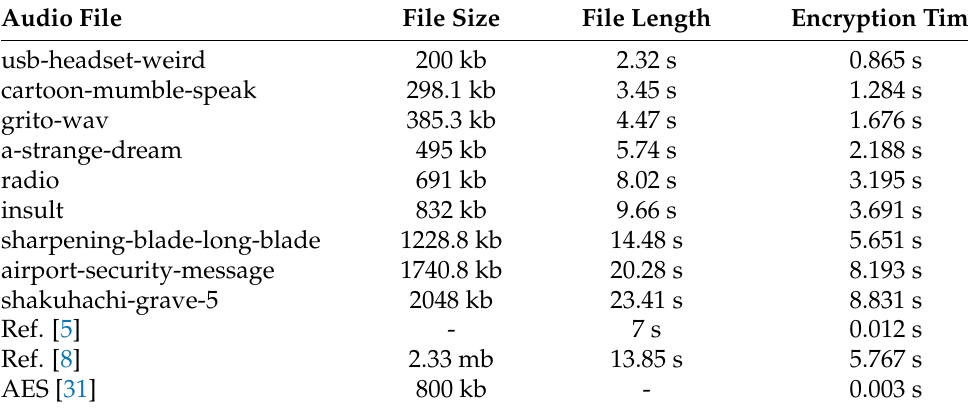
Table 4. Speed performance